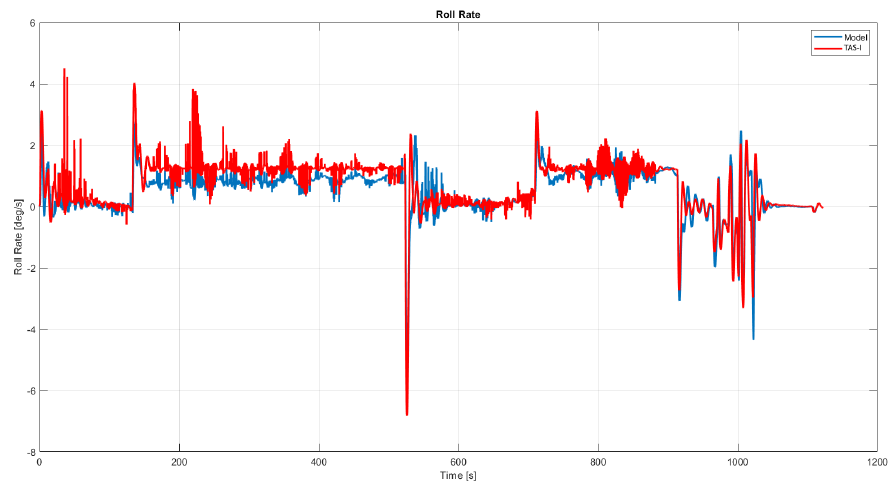
Figure 9. Roll rate comparison with the TAS − I drop test data.